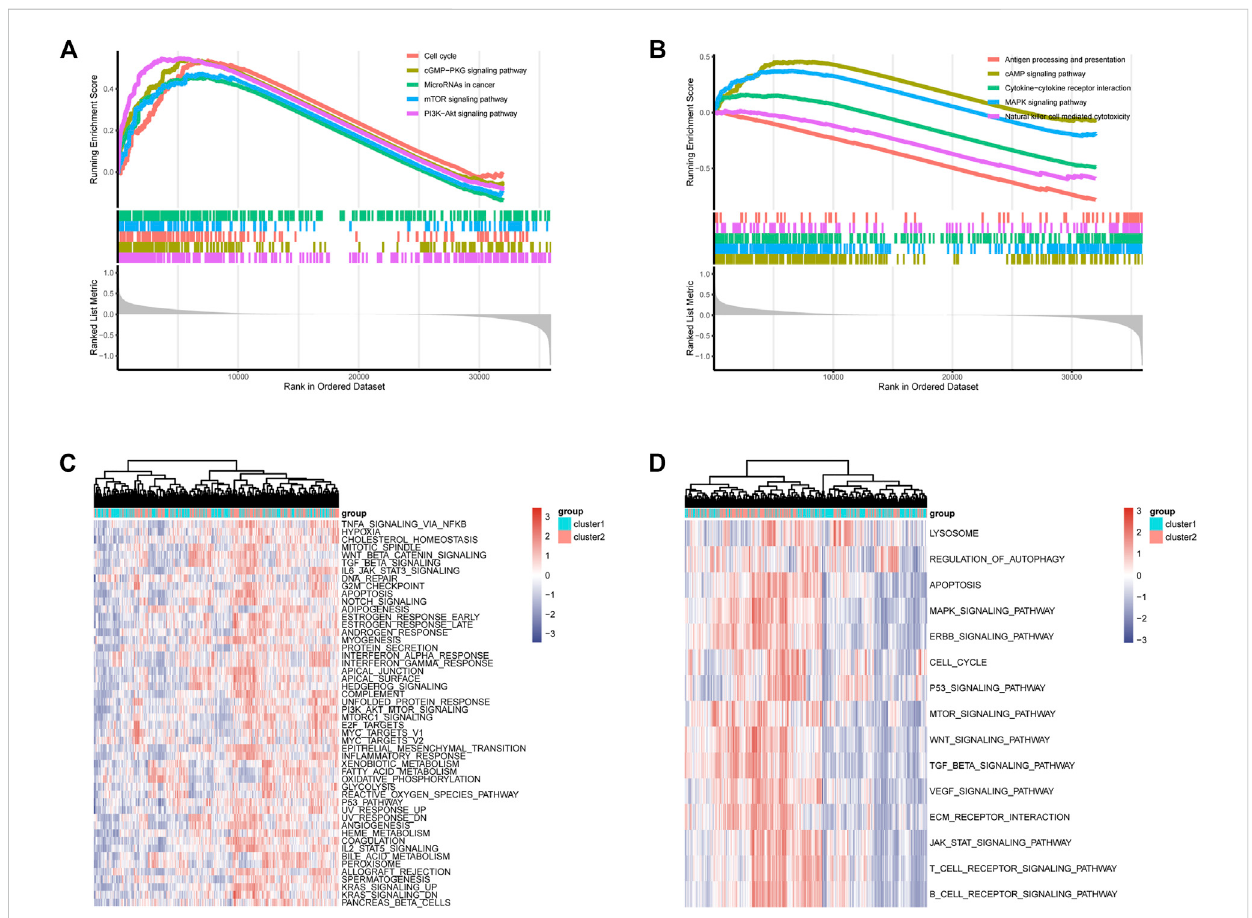
FIGURE 3 GSEA functional enrichment of DEGs and GSVA functional enrichment of two groups. (A,B) GSEA of DEGs, signaling pathways related to immunity, autophagy and proliferation. (C) GSVA (Gene Set Variation Analysis) showed the hallmark pathways differences between two groups. (D) GSVA showed differences in autophagy and proliferation-related pathways between two